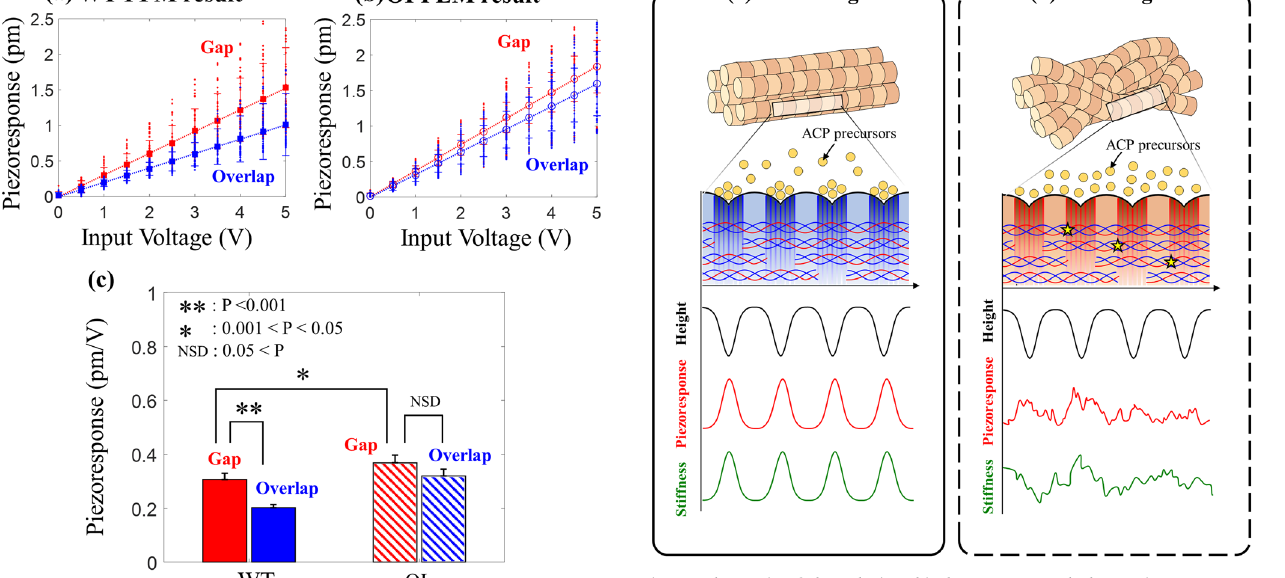
Fig. 4 Schematic of the relationship between morphology, piezoresponse, and mechanical stiffness in collagen fi brils. A schematic of relationship between morphology, piezoresponse, and mechanical stiffness of a WT collagen and b OI collagen along a fi bril. It was reported that mineralized collagen in WT bone has higher stiffness at each gap zone, which corresponds with the piezoresponse pattern observed in this study. On the other hand, no such stiffness pattern of mineralized OI collagen was observed previously and, likewise, no piezoelectric pattern of OI collagen was measured, although the morphology of the OI collagen was similar to the WT collagen. This result emphasizes the role of collagen piezoelectricity for ACP in fi ltration through the gap region.